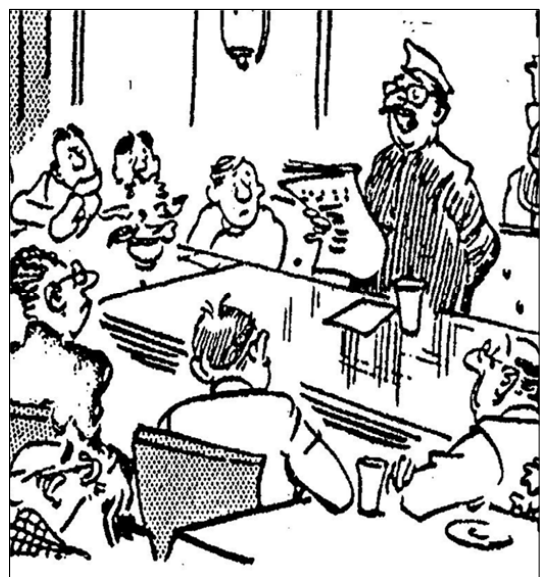
Figure 1. “The figures I have given are wrong. That is because I don’t have the right figures” (unknown source).